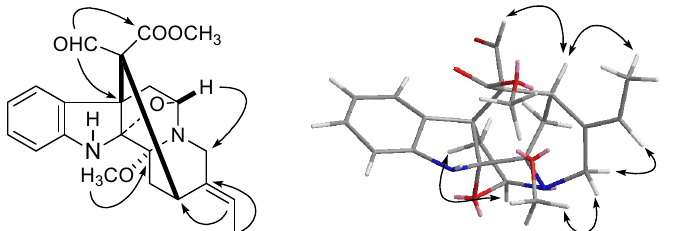
Figure 2. Key HMBC ( ) and NOESY ( ) correlations of of compound 1